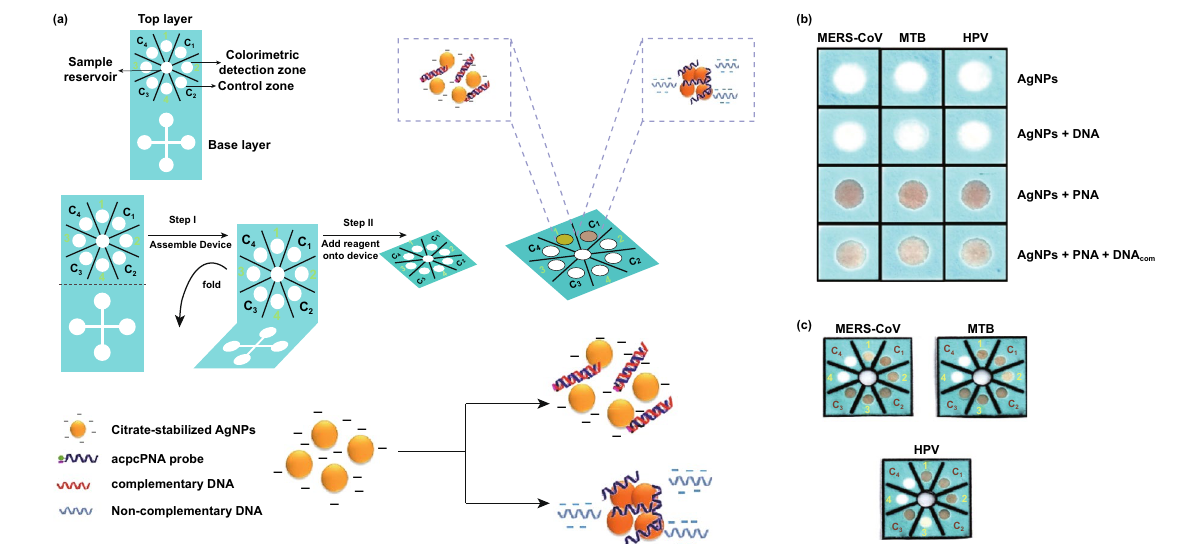
Fig. 9 a Designing and b photograph of visual color alterations got from the recognition of 205 HPV, MTB, and MERS‑CoV in the DNAcom presence. After acpcPNA addition, the yellow AgNPs turned red. The color also turned red because of AgNPs aggregation when the solution consists of the DNAnc and acpcPNA. On the other hand, altering the color from red (aggregation state) to yellow (non‑aggregation state) in DNAcom presence, the intensity dependence on the DNA concentration is clear. c Selecting 100 nM MERS‑CoV, MTB, and HPV recognition with the help of a multiplexed colorimetric sensor. Adapted from Ref. [87]. (Color figure